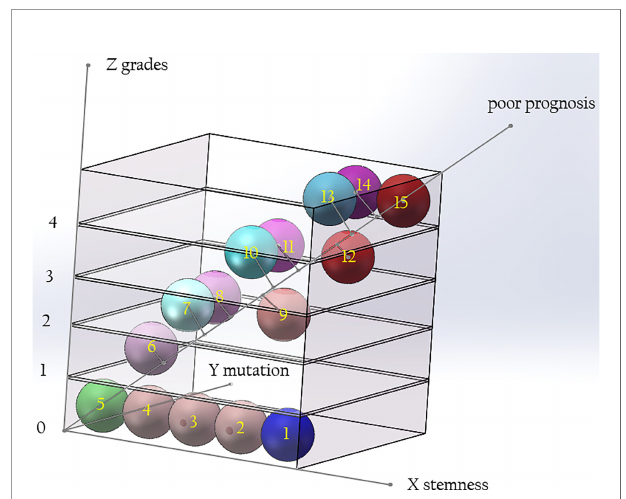
FIGURE 5 | The relationship among the grade of gliomas, the tumorigenicity of mutations, and the stemness of originate cells. The malignancy of glioma is determined by the tumorigenic ability of gene mutation and the stemness of originate cells. With the improvement of the tumorigenicity of the mutant genes and the increase of the stemness of the originated cells, the grade of the tumor increases. Compared with solitary gliomas of the same grade, MCG have similar tumorigenicity of mutant genes, but the stemness of the originated cells is increased. The diagonal of the cube signi fi es poor prognosis. Along the direction far from 0, the prognosis of patients will be worse. (X axis: stemness of originated cells; Y axis: tumor grade; Z axis: tumorigenicity of mutant genes. 1, neural stem cell; 2-4, precursor cells; 5, mature neural cells; 6, glioma of WHO grade I; 7, diffuse astrocytoma/ oligodendroglioma, IDH mutant, grade 2; 8, diffuse astrocytoma, IDH wide type, grade 2; 9, MCG, grade 2; 10, diffuse astrocytoma/oligodendroglioma, IDH mutant, grade 3; 11, diffuse astrocytoma, IDH wide type, grade 3; 12, MCG, grade 3; 13, diffuse astrocytoma, IDH mutant, grade 4; 14, glioblastoma, IDH wide type, grade 4; 15, MCG, grade